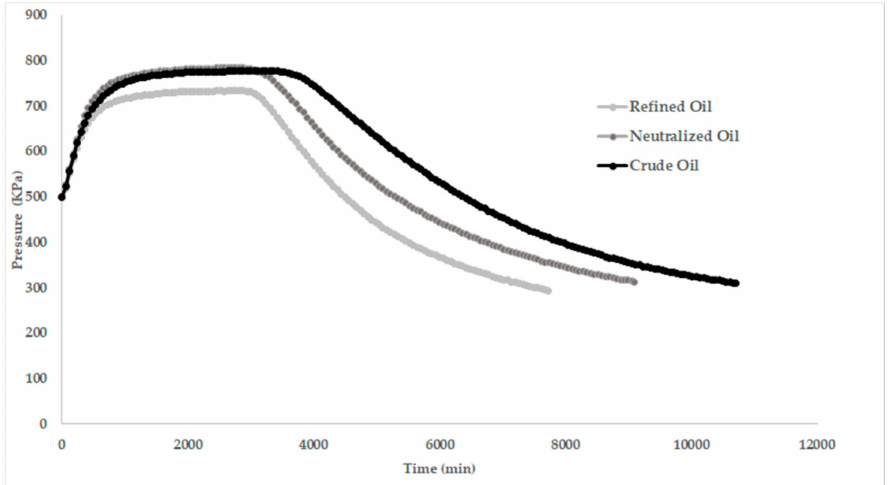
Figure 4. Oxidation stability of oil over time at different steps of the refining